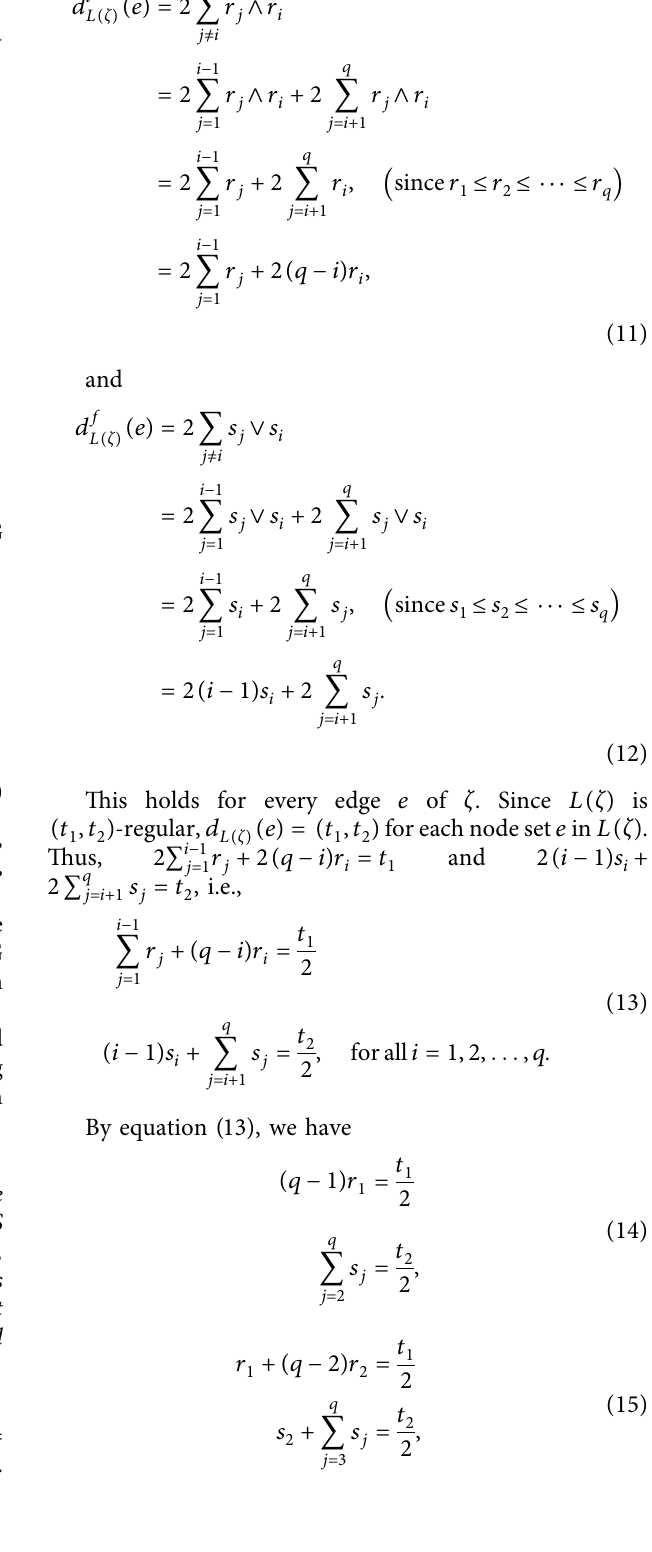
, d ) -regular vague graph with G ∗ cyclic and 2- 1 2